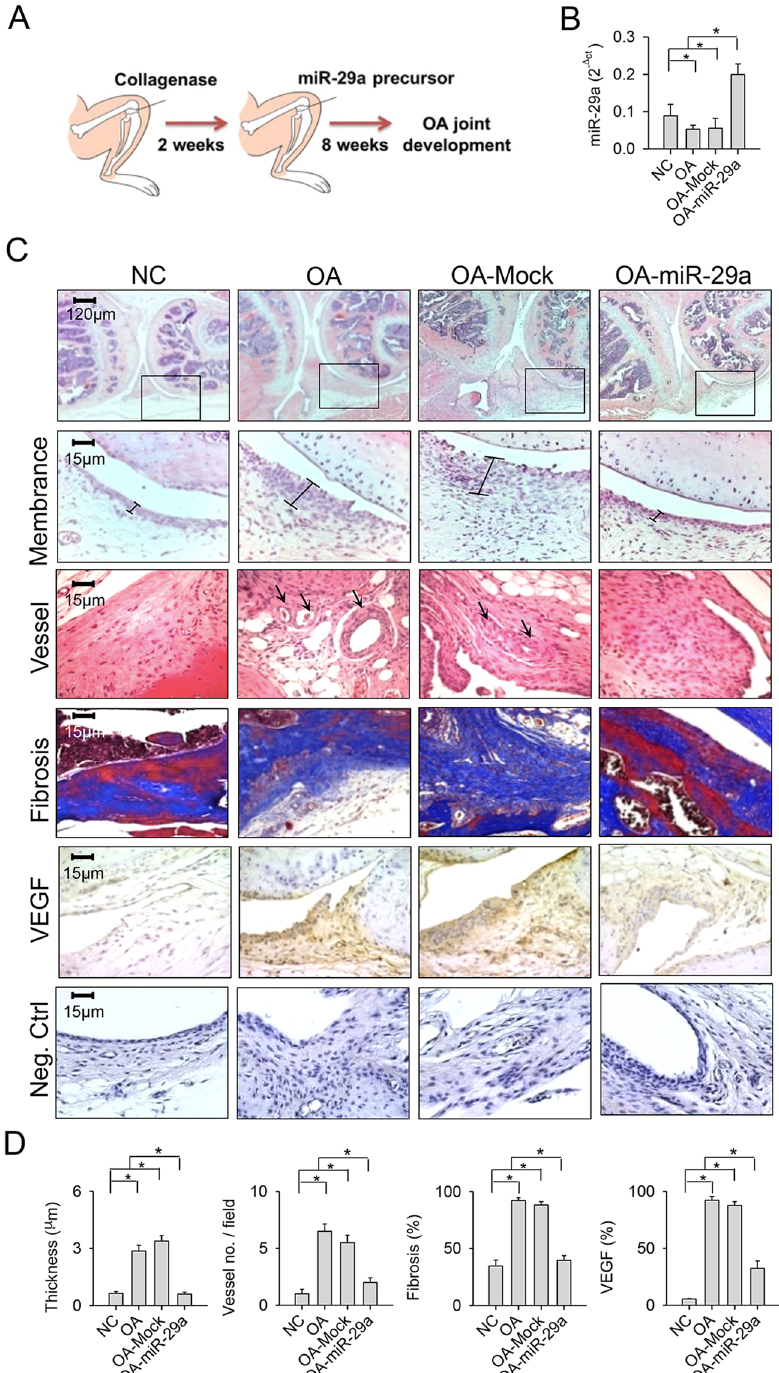
Figure 5. Effects of exogenous miR-29a administration on synovial histology. ( A ) Scheme of miR-29a administration of collagenase-affected knees. ( B ) Synovial tissues exhibited high miR-29a expression after treatment. ( C ) The treatment attenuated cartilage damage, hyperangiogenesis (arrows), fibrosis, and VEGF immunostaining in collagenase-affected synovial tissue. Panels in the lower power field images indicate area of interest for the high power field images of synovial membrane. ( D ) Membrane thickness, vessel number, fibrosis area, and VEGF expression within affected synovium were lessened after miR-29a treatment. Each bar plot stands for mean ± standard error calculated from 8 animals in each group and analyzed by a parametric analysis of variance (ANOVA) and a Bonferroni post-hoc test. Asterisks ( * ) stands for significant difference between